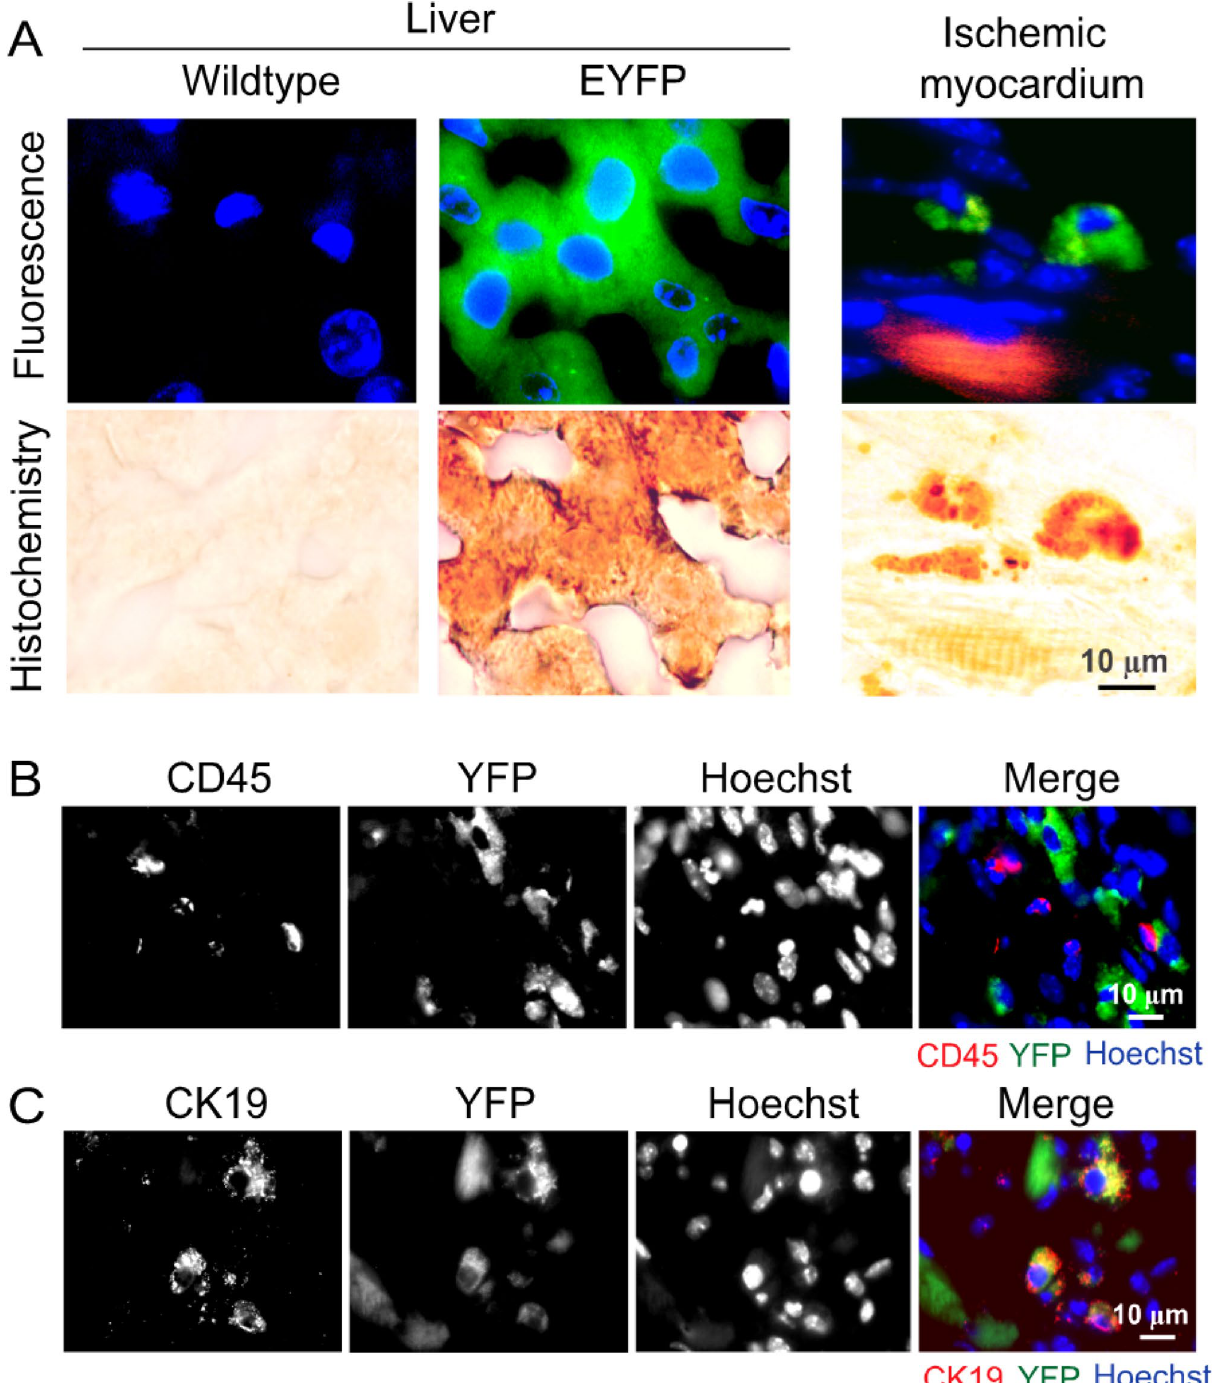
Figure 2. Characterization of hepatic cells in the liver and ischemic myocardium. ( A ) Confirmation of eYFP- positive hepatic cells in the liver and ischemic myocardium of Alb-Cre/eYFP mice with 5-day MI-R injury by fluorescence and immunohistochemistry microscopy. Each pair of fluorescence and immunohistochemistry images was from the same specimen. Green: eYFP. Red: Antibody-labeled cardiac troponin I. Blue: Hoechst 33,258-stained cell nuclei. Brown: Antibody-labeled eYFP by immunohistochemistry. The length scale is for all panels. ( B , C ) Fluorescence micrographs showing eYFP-positive cells, CD45-positive cells, and cytokeratin 19 (CK19)-positive cells in the ischemic myocardium of an Alb-Cre/eYFP mouse with 5-day MI-R injury. Note co-localization of eYFP with CK19, suggesting the presence of bile ductular epithelial